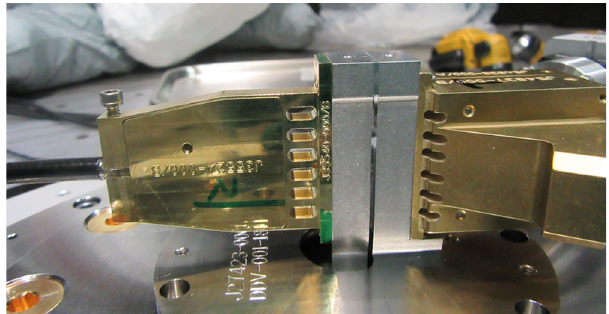
FIG. 2. Photograph of stripline load geometry installed in the Z machine prior to current discharge on experiment Z3260. The cathode stripline is on the left and can be seen passing through the D-hole. Magnetically shielded mounts housing the velocimetry probes are shown attached to both cathode and anode